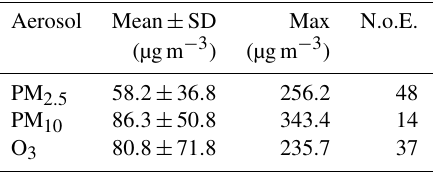
Table 5. Statistics of the maximum and number of exceedances (N.o.E) of O 3 and PM 2 . 5 compared with the National Ambient Air Quality Standards in China.